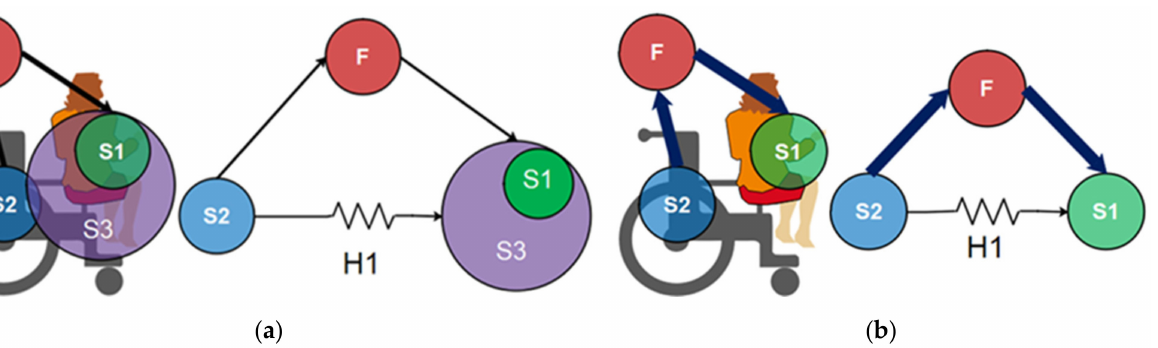
Figure 3. Block diagram ( a ) Su-field analysis, ( b ) Improved Su-field